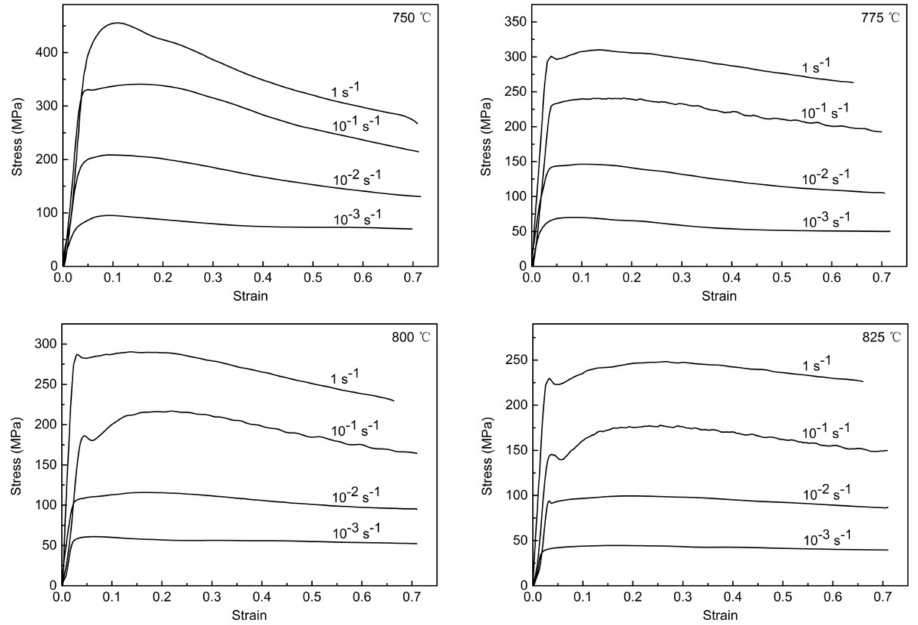
Figure 2. Curves of stress σ versus strain ε at 750–825 ◦ C and 10 − 3 − 1 s − 1